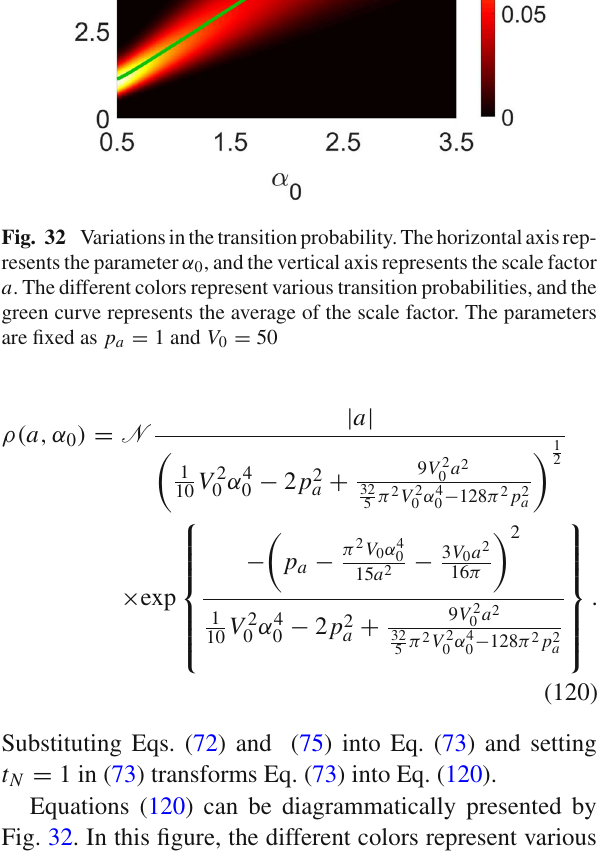
Fig. 32. In this figure, the different colors represent various transition probabilities, and the green curve represents the